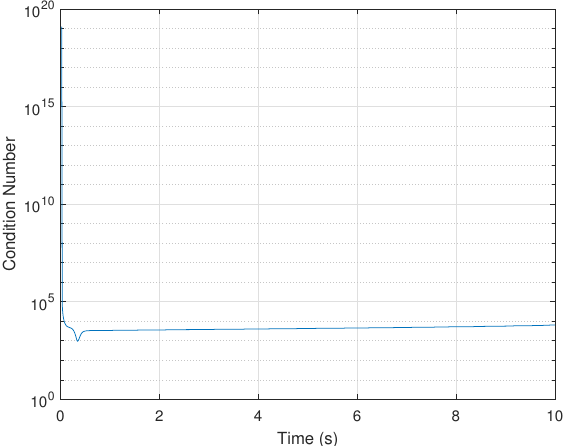
Figure 5. Empirical observability Gramian analysis: condition number of observability